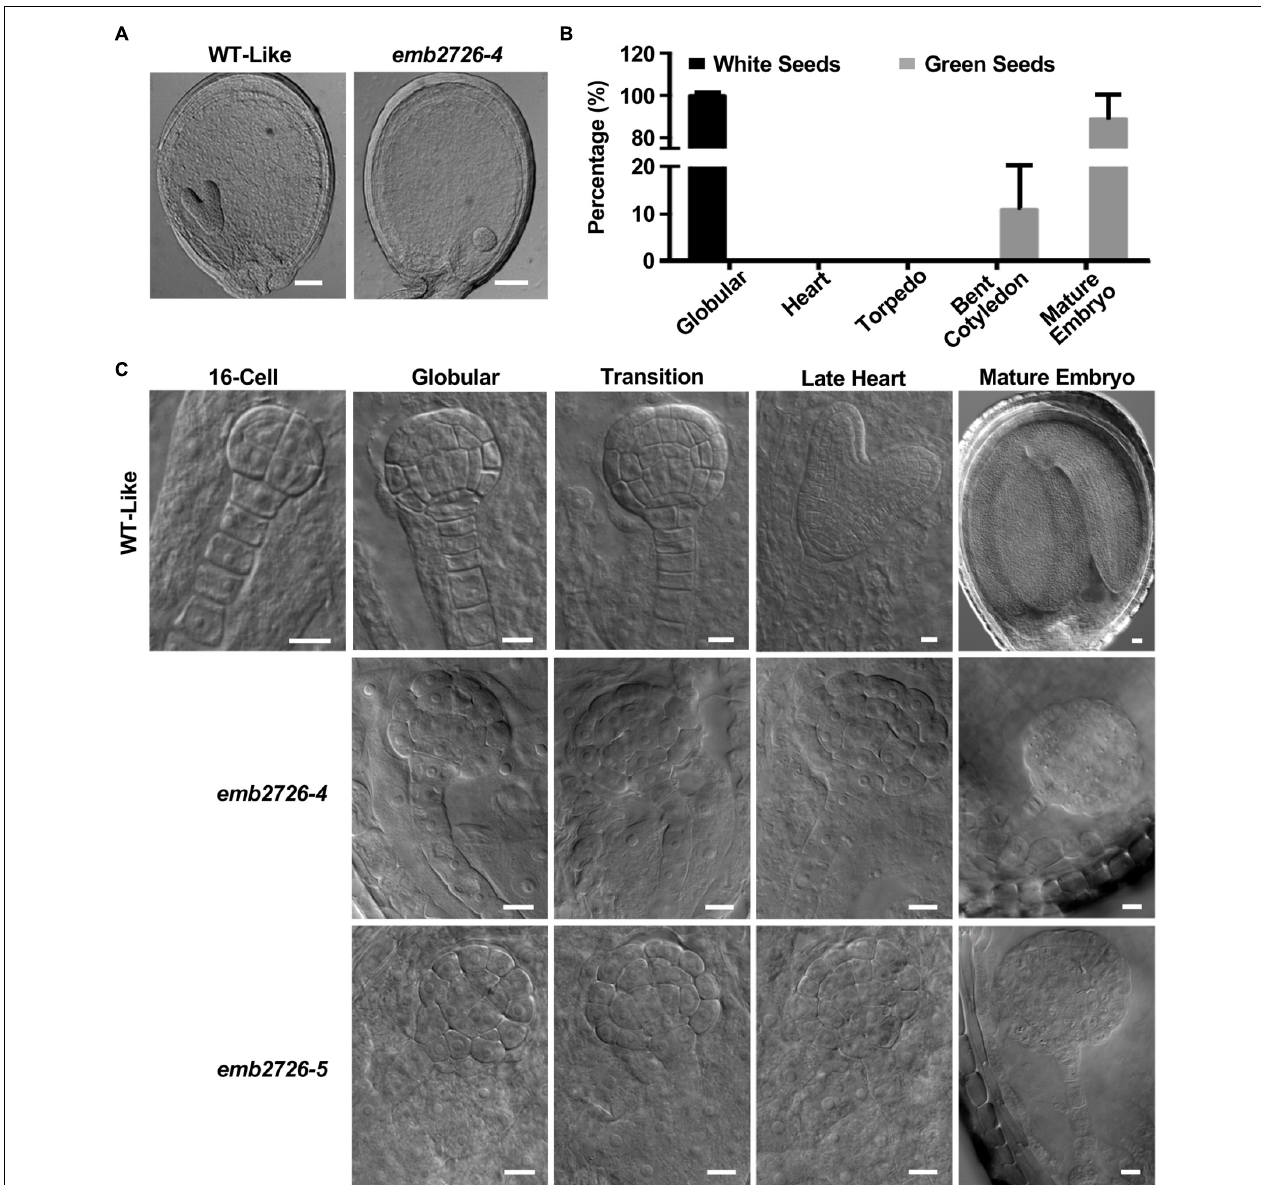
FIGURE 2 | Phenotype analysis of the emb2726 mutant embryos. (A) Phenotypes of WT and mutant seeds within the same silique at 6 DAP. Scale bar = 50 µ m. (B) Distribution of embryos at different developmental stages within the same silique from emb2726-4/ + plants at 12 DAP. (C) Phenotypes of the embryos in WT, emb2726-4 , and emb2726-5 seeds at different developmental stages. At the 16-cell stage, WT, and mutant embryos were indistinguishable. Scale bar = 10 µ